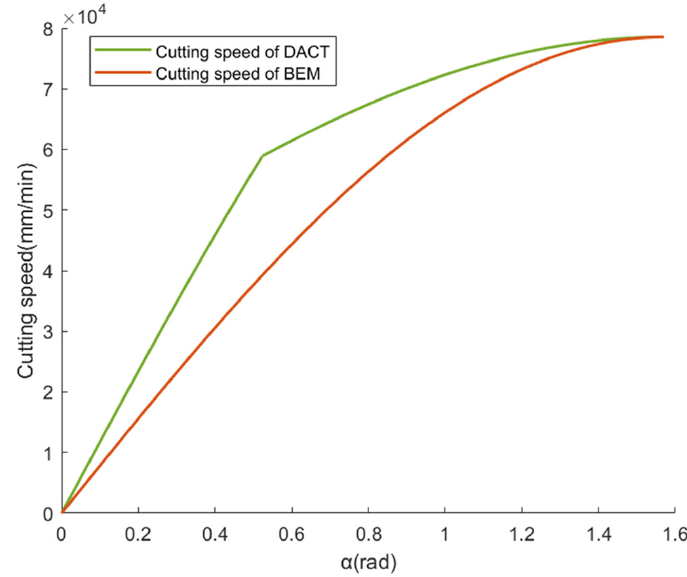
Figure 3. Comparison of effective cutting speeds.